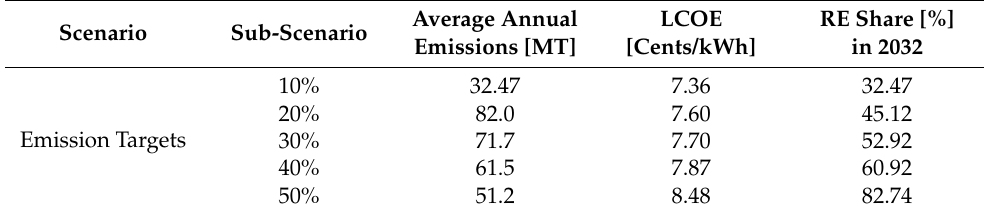
Table 19. Sensitivity analysis of emission reduction targets.